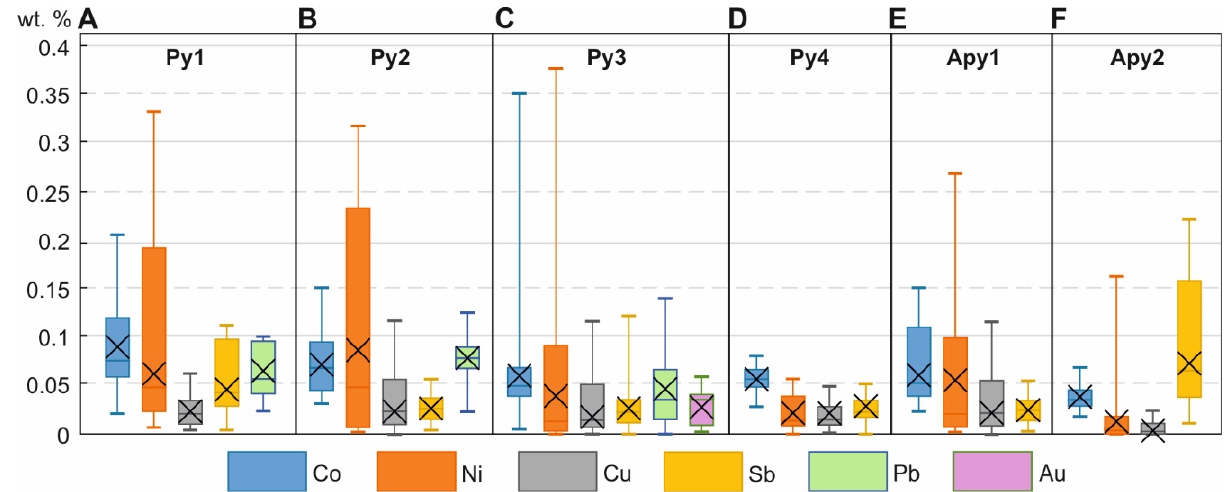
Figure 9. Trace element contents by EPMA: ( A ) Py1; ( B ) Py2; ( C ) Py3; ( D ) Py4; ( E ) Apy1; ( F ) Apy2. Box boundaries are first and third quartiles, and line in middle of box is median. Lower border of line shows minimum value, upper shows maximum value, cross shows average value.